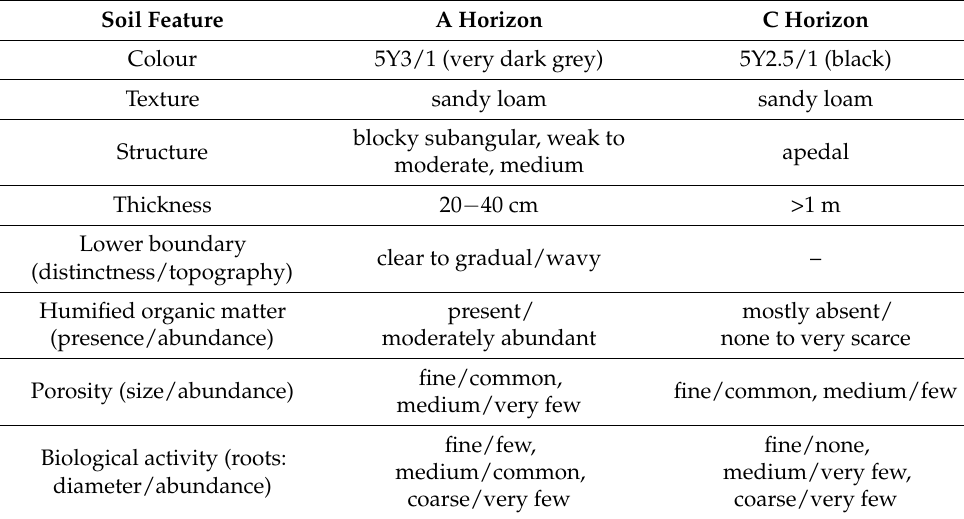
Table 1. Soil Characteristics in the Coal Mine Waste Pile with Normal Pedogenesis 1 . Soil